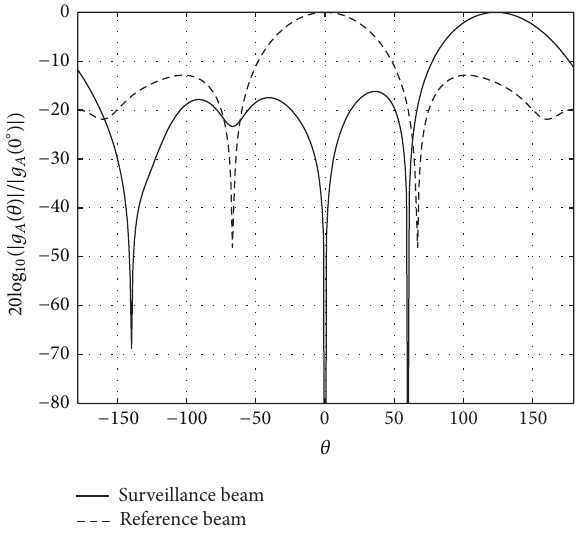
Figure 6: Example of surveillance beam and reference beam orthogonal to the surveillance one.